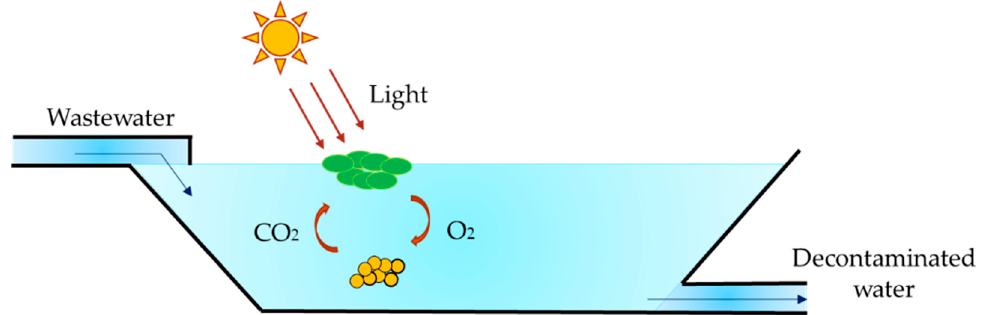
Figure 1. Hormone suppression through the use of algae and microalgae [87].